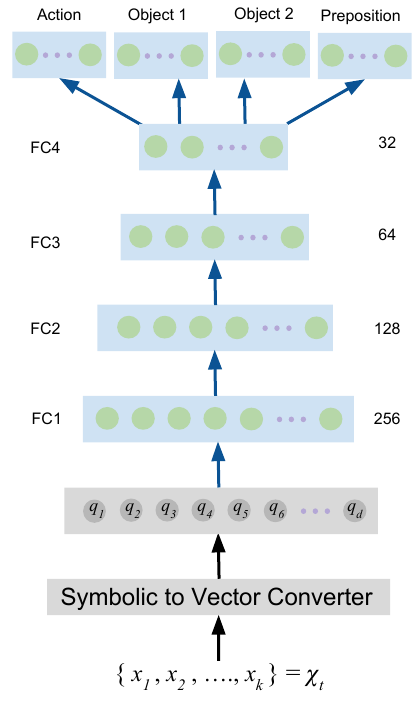
Figure 3: The deep reinforcement learning architecture. An MLP neural network is trained to approximate the action-value functions. The compositional linguistic state, χ t , is presented to the network as a compositional vector s t (see Section